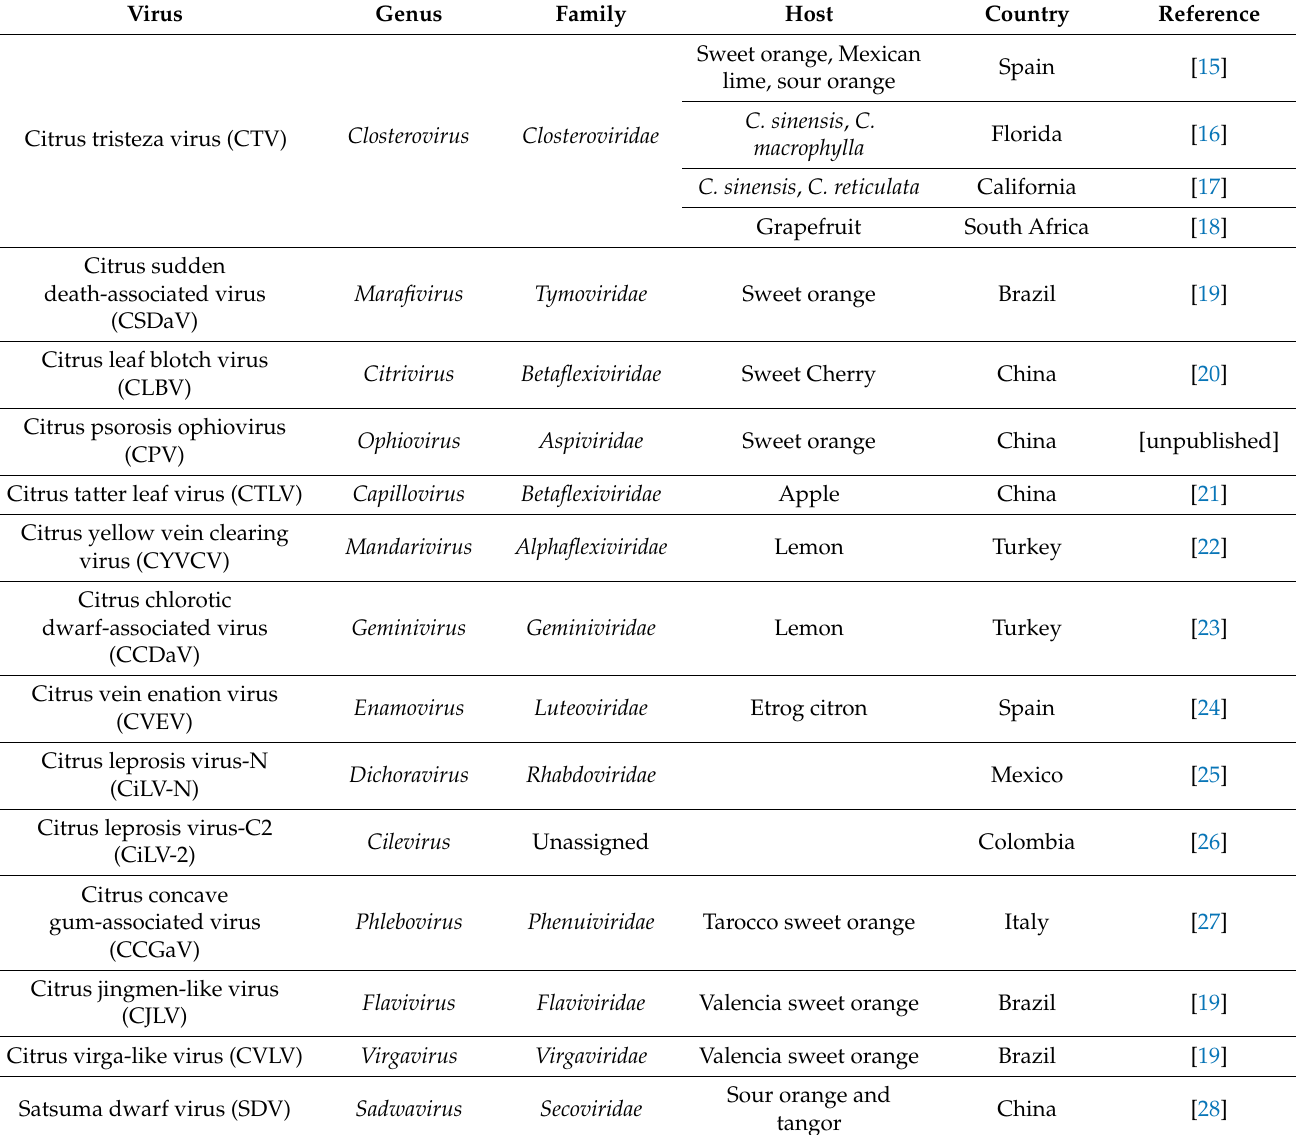
Table 1. Complete genome of citrus viruses sequenced by high throughput